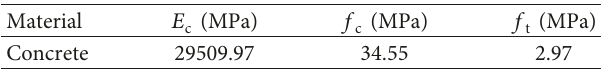
Table 2: The material parameters of concrete.